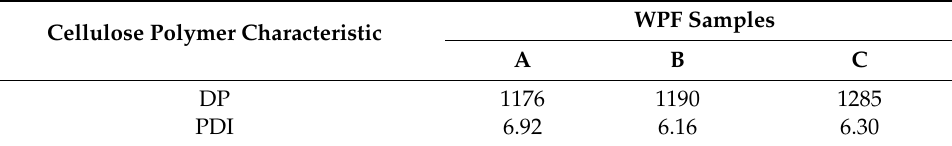
Table 3. Polymeric characteristics of cellulose in the WPF samples. DP—degree of cellulose polymer- ization; PDI—polydispersity index.